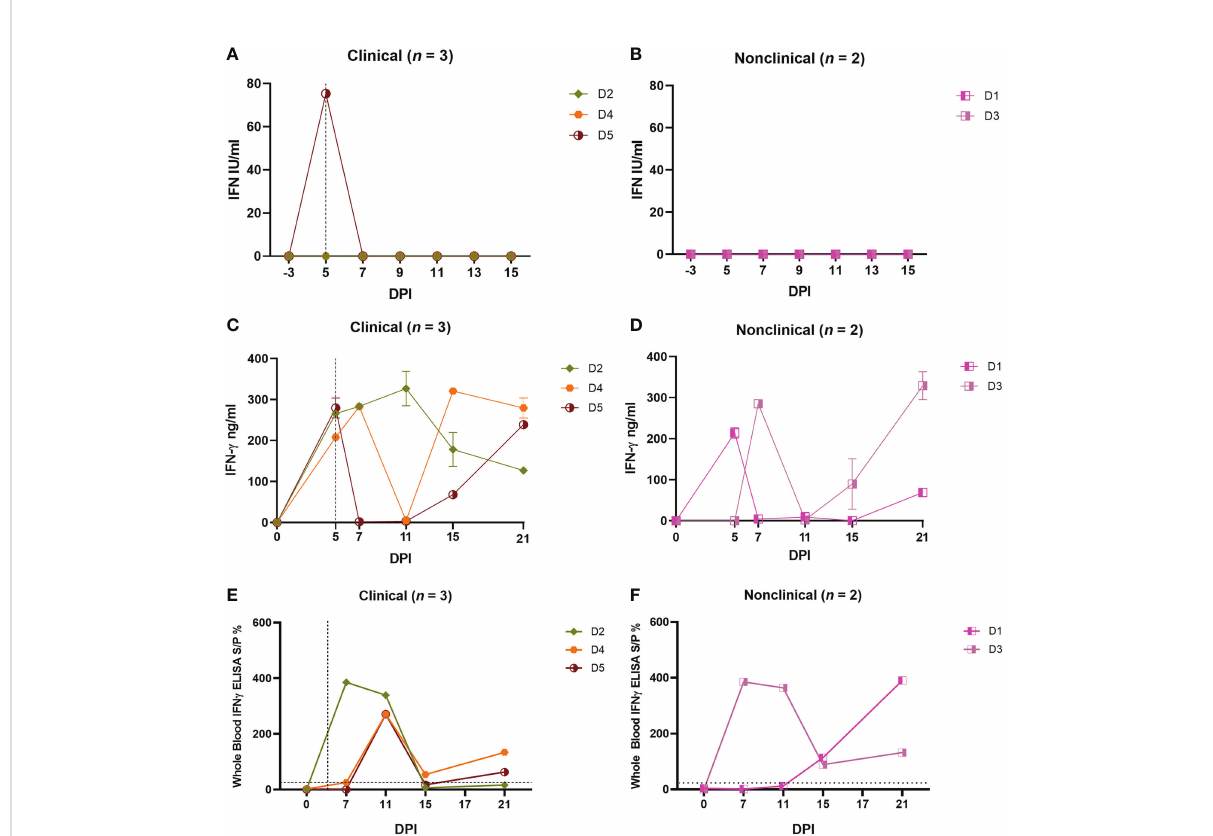
FIGURE 2 Needle – inoculated clinical and nonclinical calves produce IFN – g but not type I IFN in response to stimulation of PBMCs or blood by UV – inactivated LSDV. (A, B) The amount of type I IFN in the sera of needle – inoculated cattle at indicated timepoints post infection was quanti fi ed using a cellular reporter system (Mx/CAT assay). IGRAs were performed on PBMC puri fi ed from heparinised blood collected at indicated timepoints from clinical (C) and nonclinical (D) calves. PBMCs were stimulated overnight with UV – inactivated LSDV, supernatant collected, and IFN – g quanti fi ed using an in – house ELISA. The error bars represent the SEM. An IGRA was also performed on stimulated whole blood from clinical (E) and nonclinical (F) calves at the timepoints indicated. Whole blood was stimulated with live LSDV overnight, then IFN – g present in the plasma quanti fi ed using a commercially available ELISA. The error bars represent the SEM. The dotted horizontal line represents a 15 S/P % positive cut – off. The dotted vertical line represents the fi rst day cutaneous lesions occurred in the clinical animals. Data corrected to mock PBS